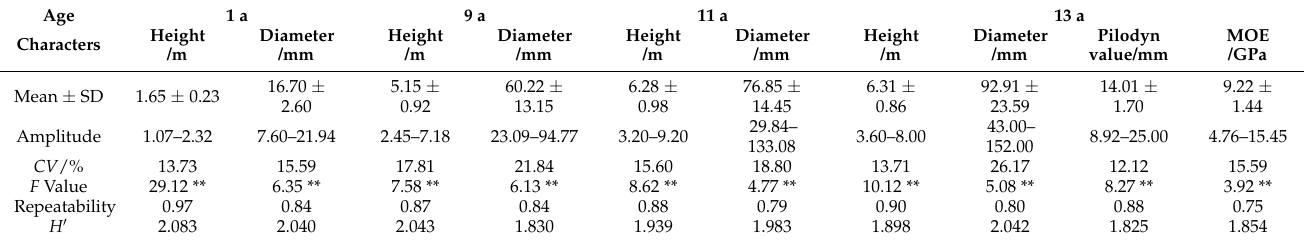
Table 2. Variance analysis and repeatability estimation of the growth and wood characteristics of the C. fargesii clones. CV , coefficient of variation; H (cid:48) , genetic diversity index **, p < 0.01.